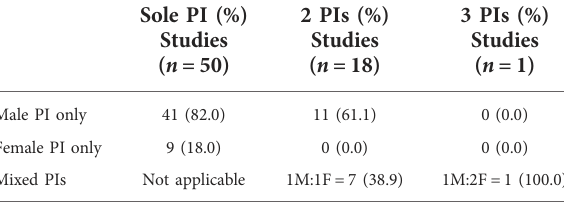
TABLE 2 Principal investigator gender according to composition of PIs within AGITG.